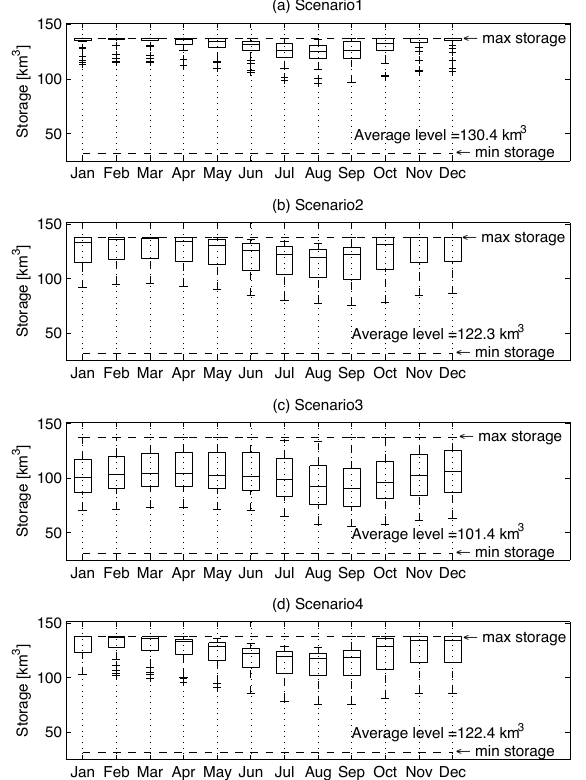
Fig. 5. Boxplots of the drawdown-refill cycles of the High Aswan Dam reservoir, for each scenario.